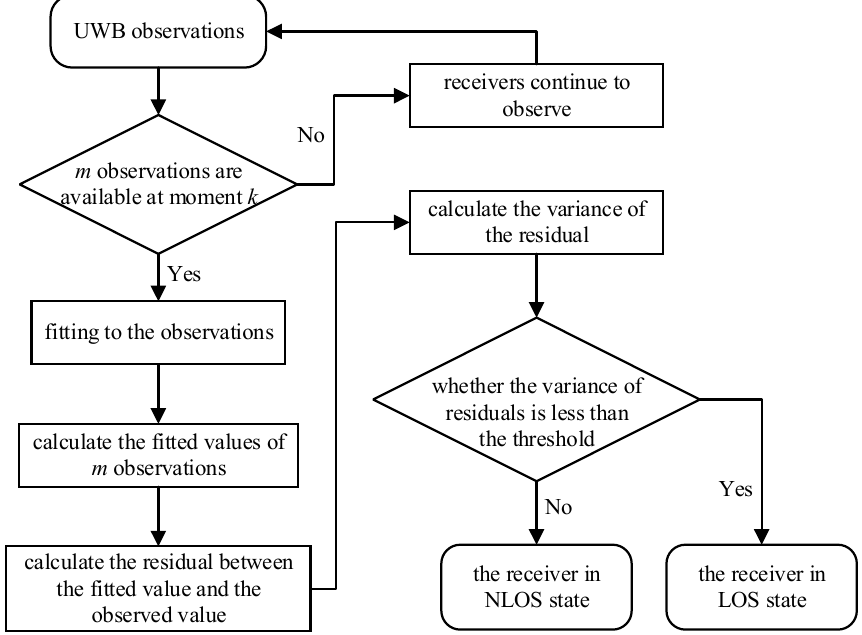
Figure 2. The sliding window recognition scheme based on polynomial